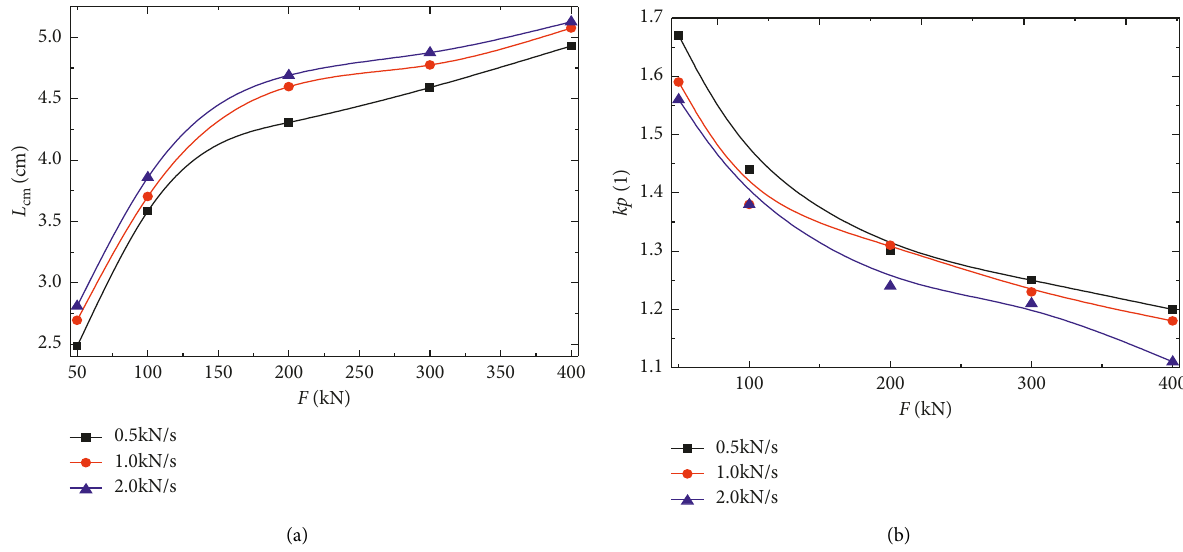
Figure 2: Variations of compression and swelling coefficient of 100 mm coal sample with the maximum quasistatic load and stress under different quasistatic load application speeds. (a) Change of compression volume. (b) Change of fragmentation and expansion